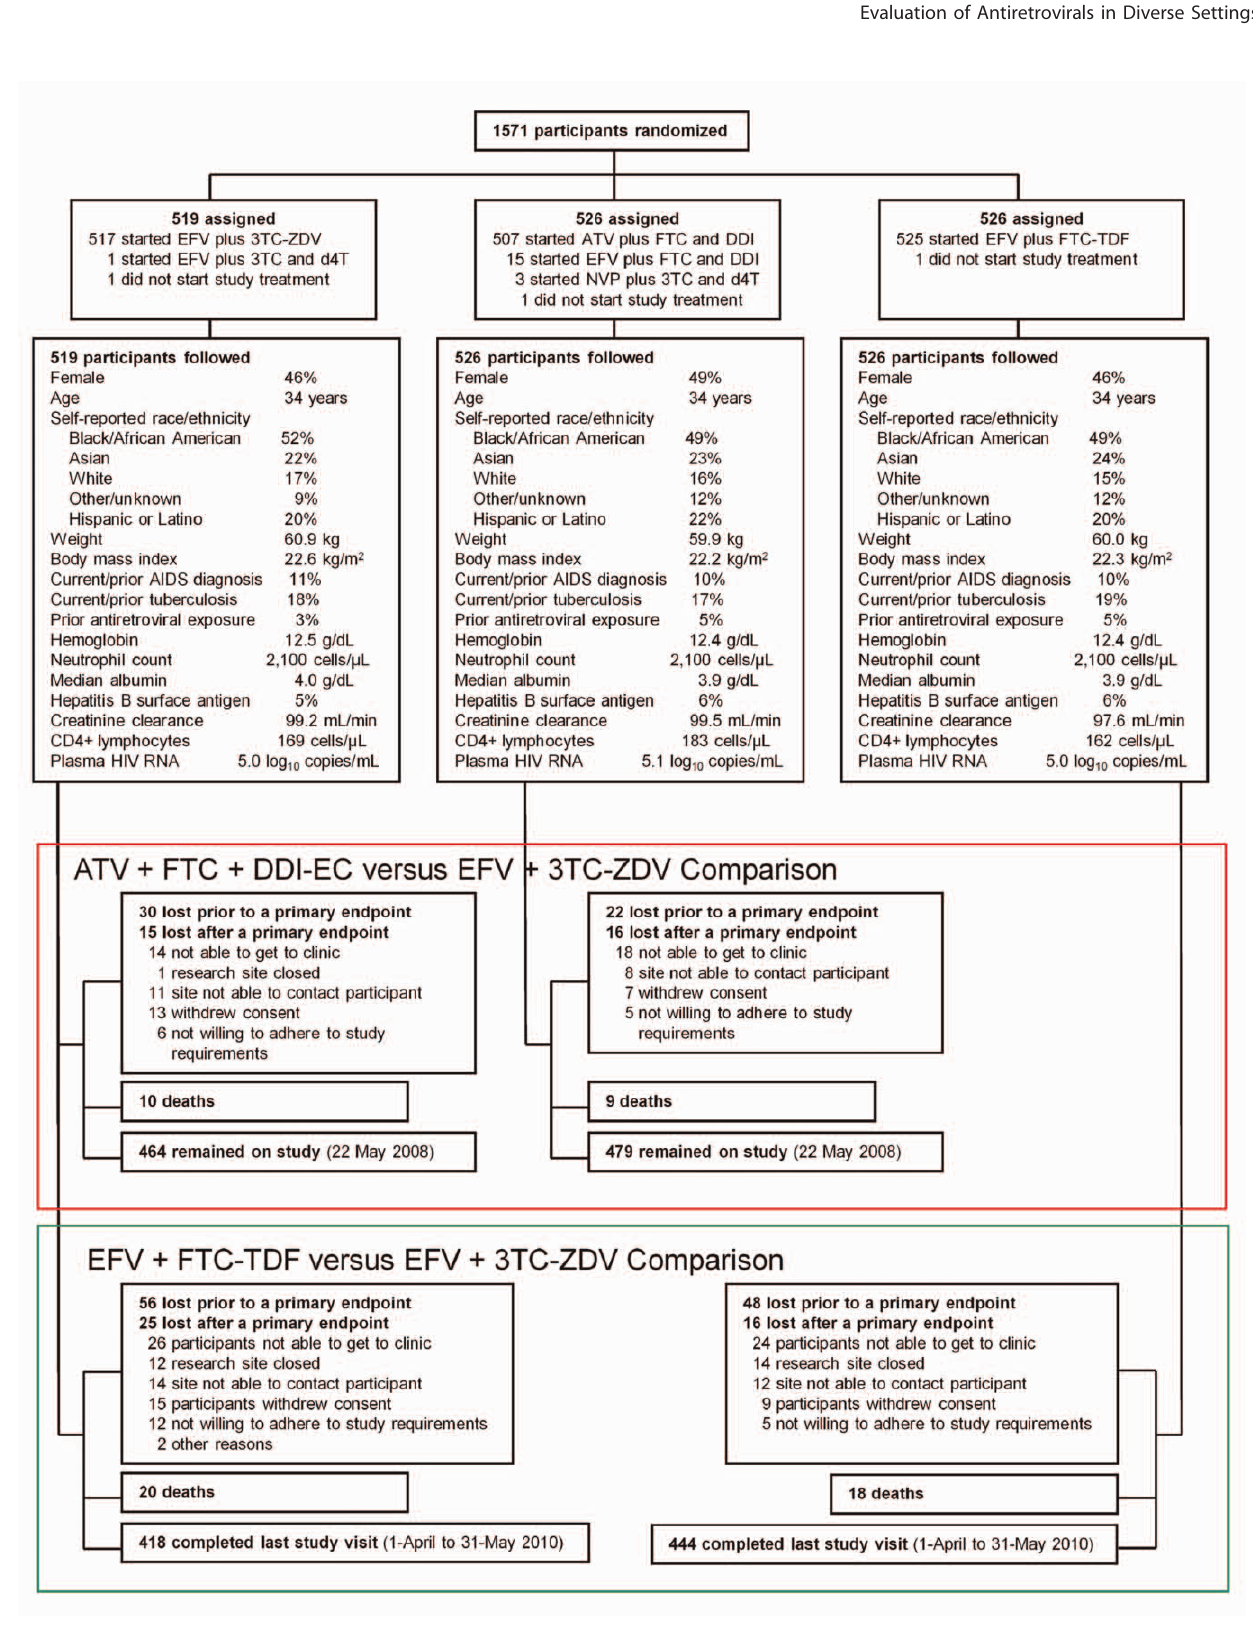
Figure 1. Flow diagram for participant outcomes. The outcomes of all participants randomized to the three arms are provided. The most common prior antiretroviral exposure was for prevention of mother-to-child transmission of HIV-1 with either ZDV monotherapy (19 women; median duration 32 d; intraquartile range 30–60 d) or a single dose of nevirapine in the peripartum period (16 women). Continuous variable values are the median for the treatment arm. Creatinine clearance was calculated by Crockoft-Gault equation. Follow-up visits were conducted for 1,571 participants. ATV plus FTC and DDI follow-up was terminated on 22 May 2008 in response to the DSMB recommendation and comparison of ATV plus